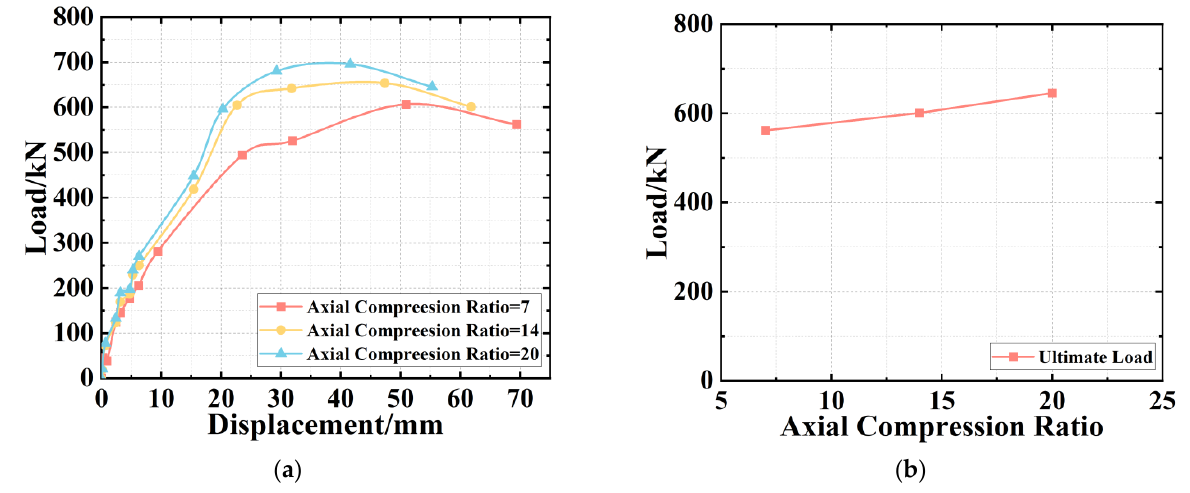
Figure 18. The Simulated Results of Different ACR . ( a ) Load – Displacement Curves. ( b ) The Ultimate Load.